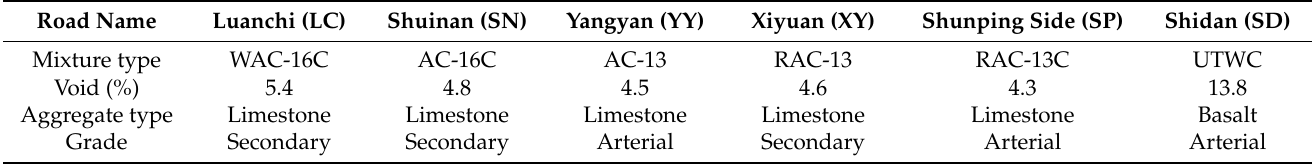
Table 1. Main information of the six actual tested roads.